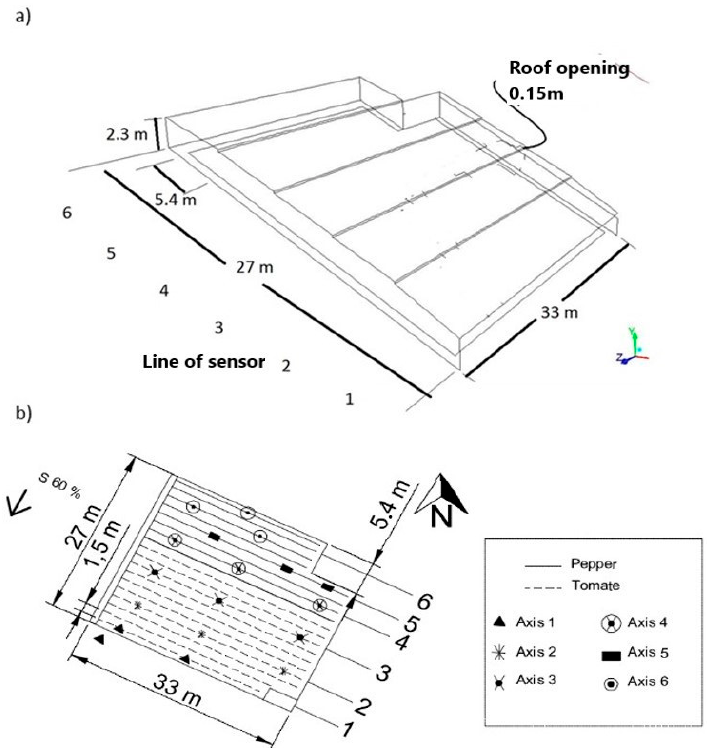
Figure 1. ( a ) Dimensions of the experimental greenhouse and ( b ) Installation of the sensors. For data acquisition of climatic variables, a weather station (Vantage Pro2 Plus, Davis Instruments, Hayward, CA, USA) was installed 50 m northwest of the greenhouse location and 1.5 m high to record the environmental variables of solar radiation, RH, and tempera- ture every 15 min (Table 1). In the greenhouse, 17 Temperature ( ◦ C) and RH (%) sensors (HOBO U10/003, Onset Computer Corporation, Bourne, MA, USA) were installed 1.65 m from the floor, divided into three perpendicular blocks and six lines parallel to the slope to analyse the differences in the slope and cross-section every 5 min (Figure 1b). Table 1. Range of measured and precision of climate sensors. Sensor